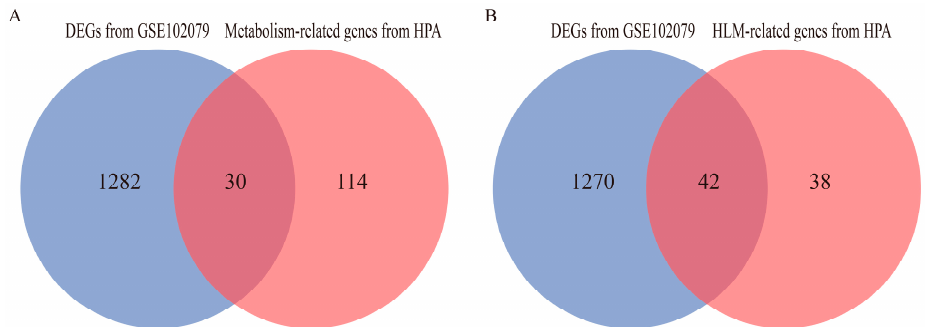
Figure 3. Venn diagrams of overlapping genes. ( A ) Thirty overlapping genes between 1312 DEGs (from the GSE102079 dataset) and 144 hepatic metabolism-related genes (from a gene expression cluster of the HPA website) represent hepatic metabolism-related DEGs in a Venn diagram. ( B ) Forty-two overlapping genes between 1312 DEGs (from the GSE102079 dataset) and 80 hepatic HLM-related genes (from a gene expression cluster of the HPA website) represent hepatic HLM-related DEGs in a Venn diagram.